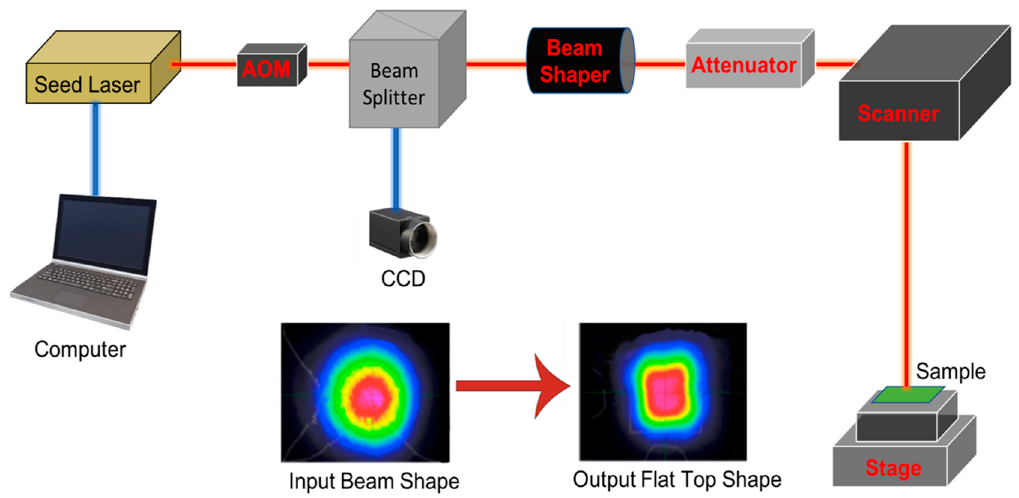
Figure 1. The schematic of the experiment setup for the fabrication of nanostructures on a metal surface. AOM: acoustic optical modulator. The devices in red text were assembled to allow for the adjustment of the process parameters.